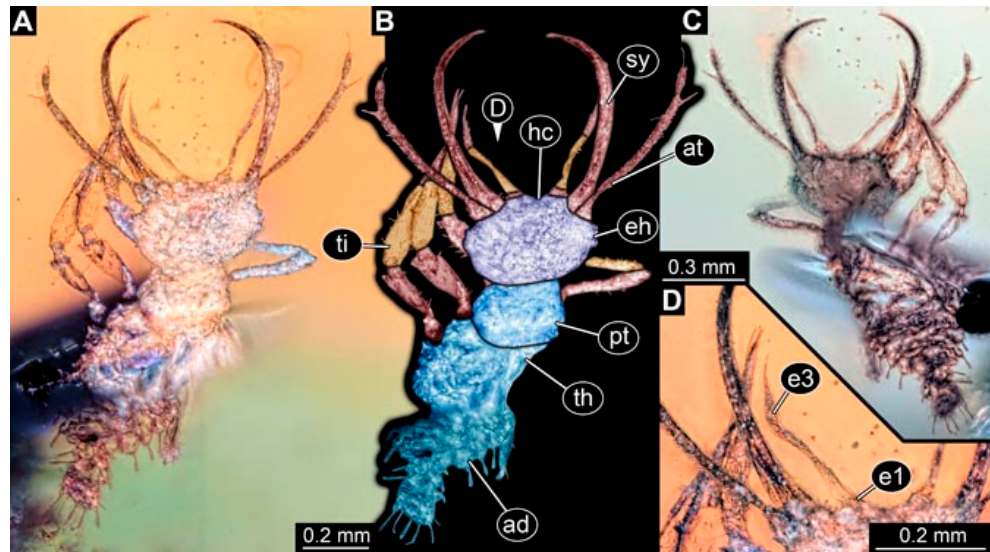
Figure 15. Specimen 4835 (PED 0253); Myanmar amber. ( A ) Dorsal view. ( B ) Dorsal view, colour- marked. ( C ) Ventral view. ( D ) Close-up of labial palp in dorsal view. Abbreviations: ad = abdomen; at = antenna; e1, e3 = element 1, 3; eh = eye hill; hc = head capsule; pt = prothorax; sy = stylet; th = thorax; ti = tibia.